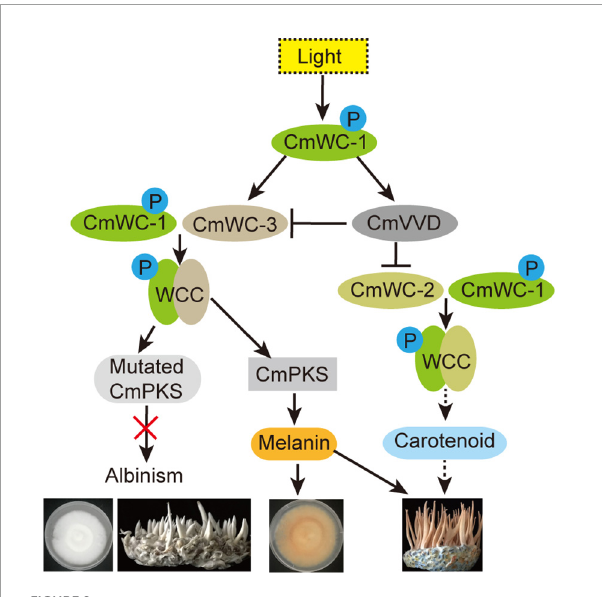
FIGURE9 Regulation network of albinism in C. militaris . P, indicates phosphorylation; black one-way solid line, positive regulation; black one-way dotted line, maybe positive regulation; black line ending with bar, indicates inhibition; red fork, function loss of